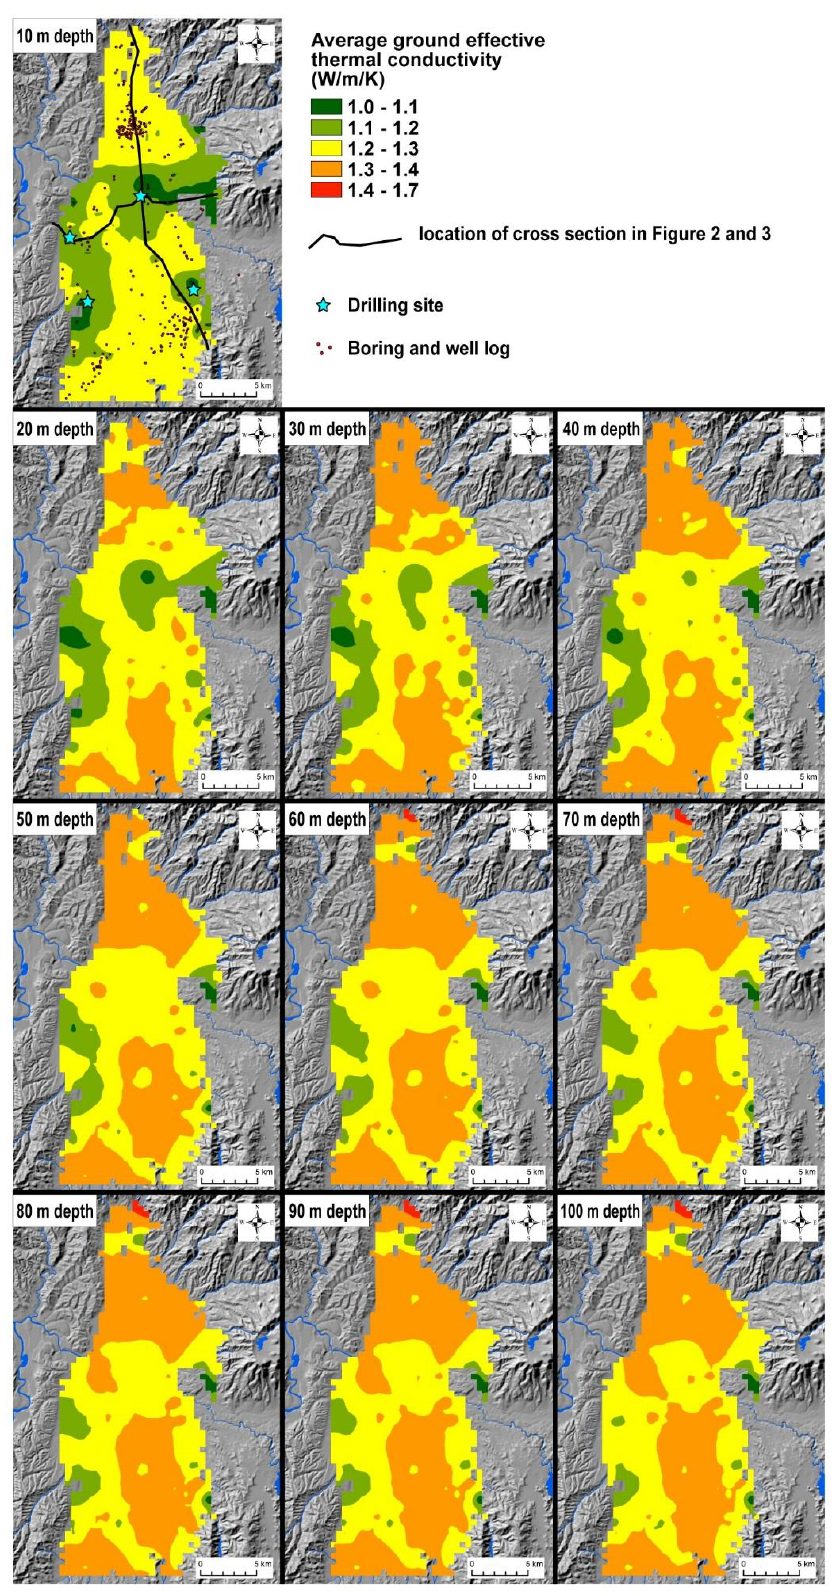
Figure 6. Distribution map of the average ground thermal conductivity from − 10 m to − 100 m depth. The relief map and elevation contour lines are drawn from the 50 m grid digital elevation map of the Geospatial Information Authority of Japan (GSI).